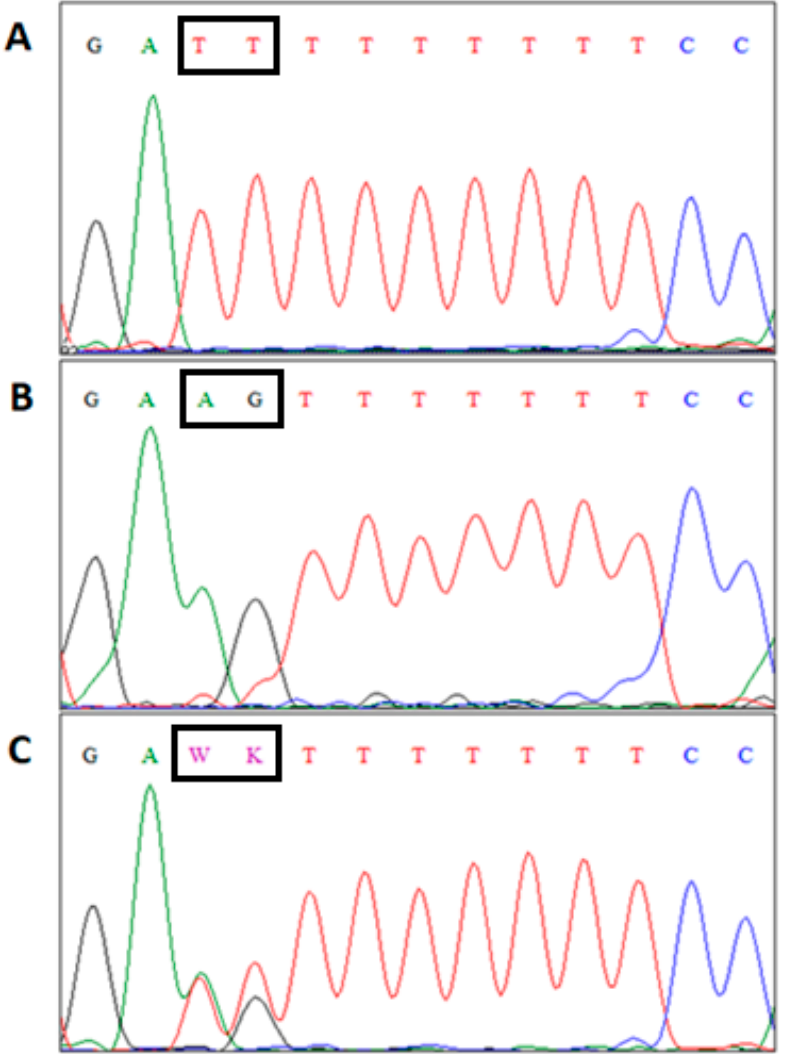
Figure 1. The results of sequencing analysis of CRY1 gene. ( A )/ CRY1 TT/TT genotype, ( B )/ CRY1 AG/AG , ( C )/ CRY1 AG/TT ; W = A or T; K = G or T. Table 2. Mean values of AP in relation to CRY1 genotypes and the race